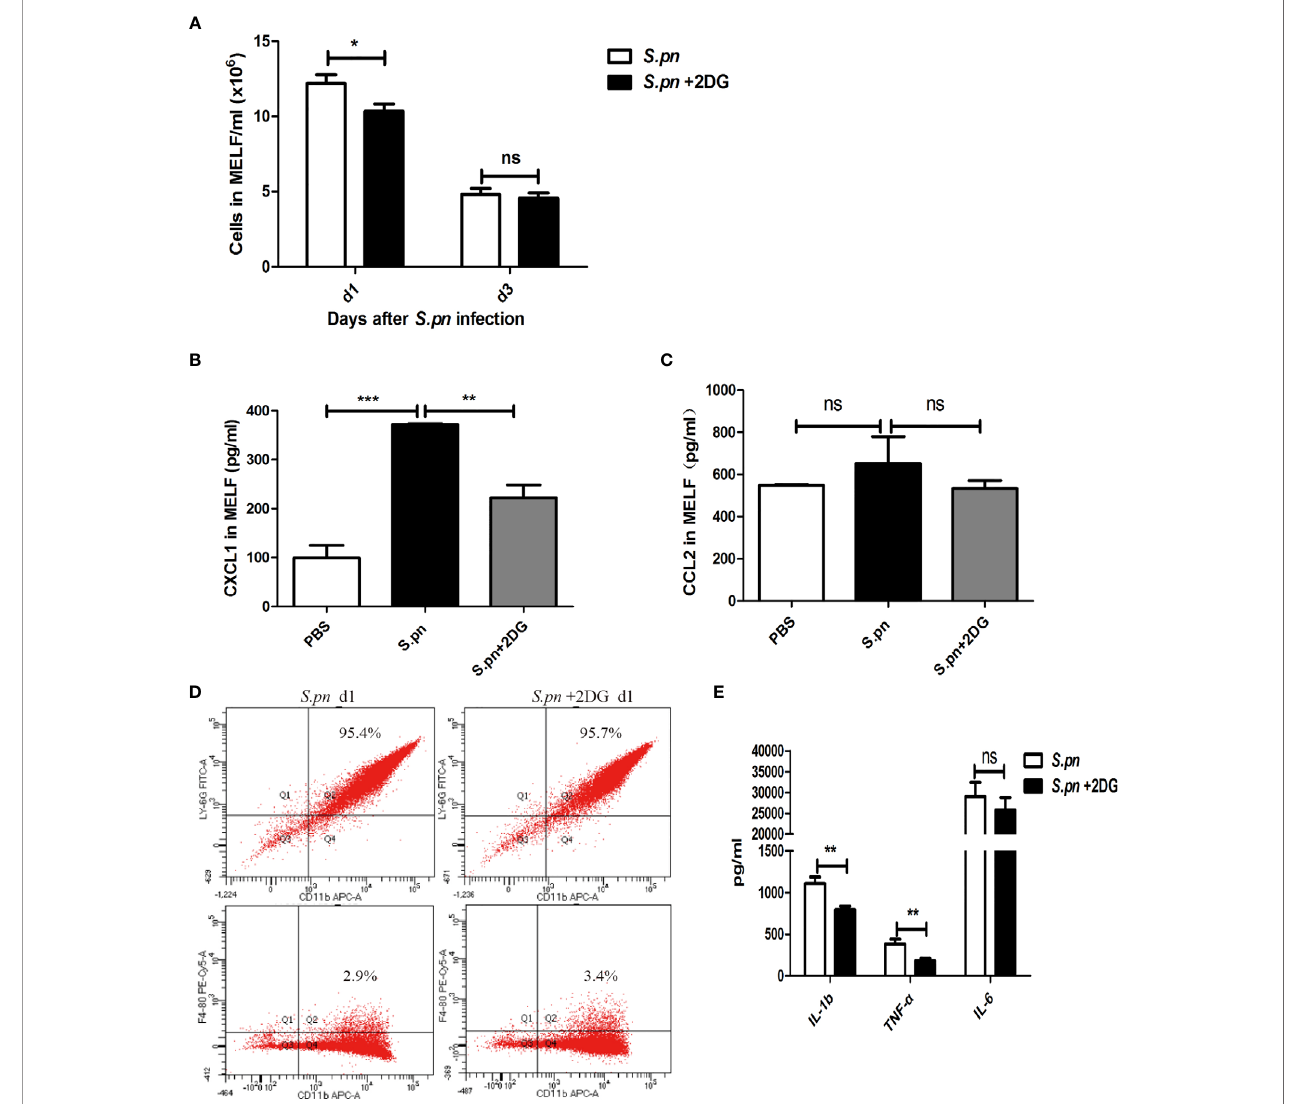
FIGURE 2 | Glycolysis promotes in fl ammatory responses during AOM. (A) In fl ammatory cells in MELF at designated time points post-infection were quanti fi ed (n=18). (B) Chemokines CXCL1 and (C) , CCL2 in MELF were detected by ELISA. (D) The proportion of neutrophils (CD11b+Ly6G+) and macrophages (CD11b+F4/ 80+) in the MELF was detected by fl ow cytometry. (E) Cytokines in MELF were detected by ELISA. Data represent three independent experiments and are presented as mean ± SD (n = 3). *P <.05; **P <.01; ***P <.001. ns, not signi fi